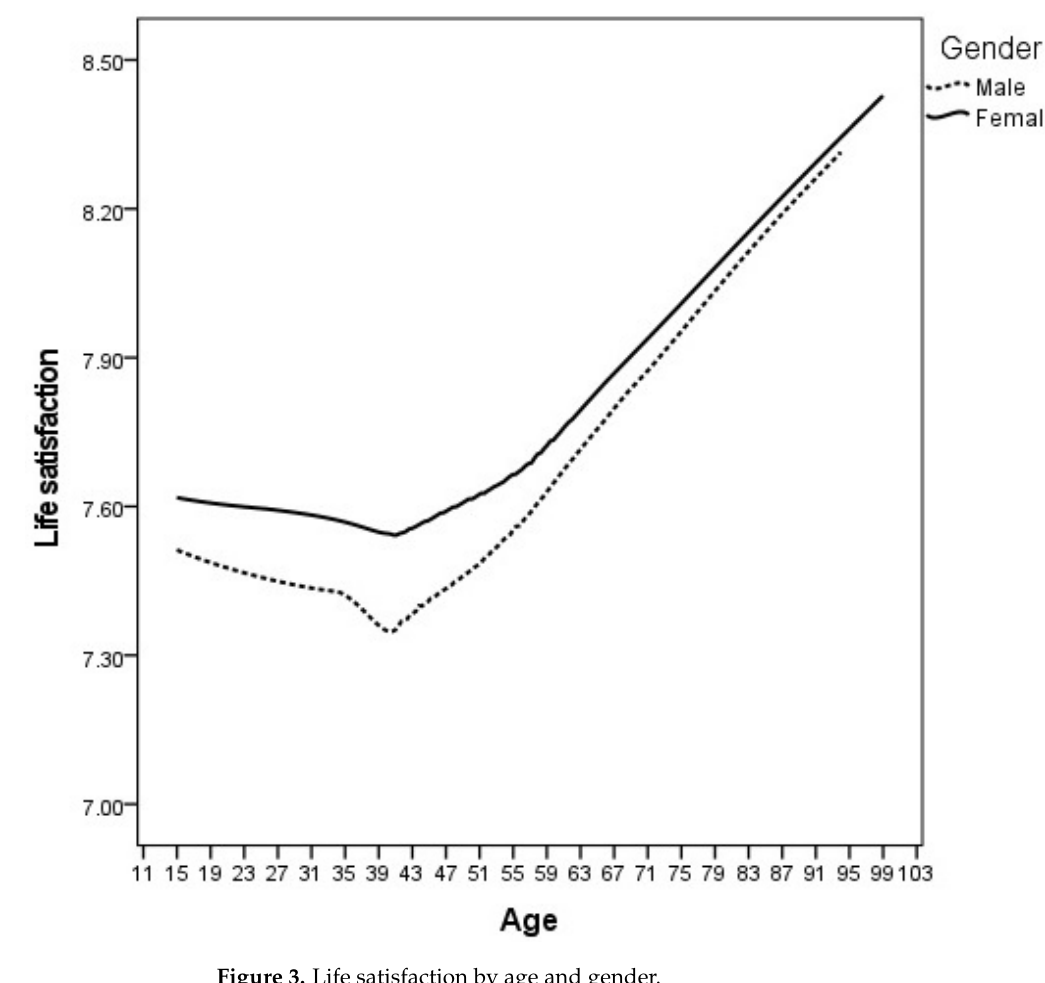
Figure 3. Life satisfaction by age and gender.